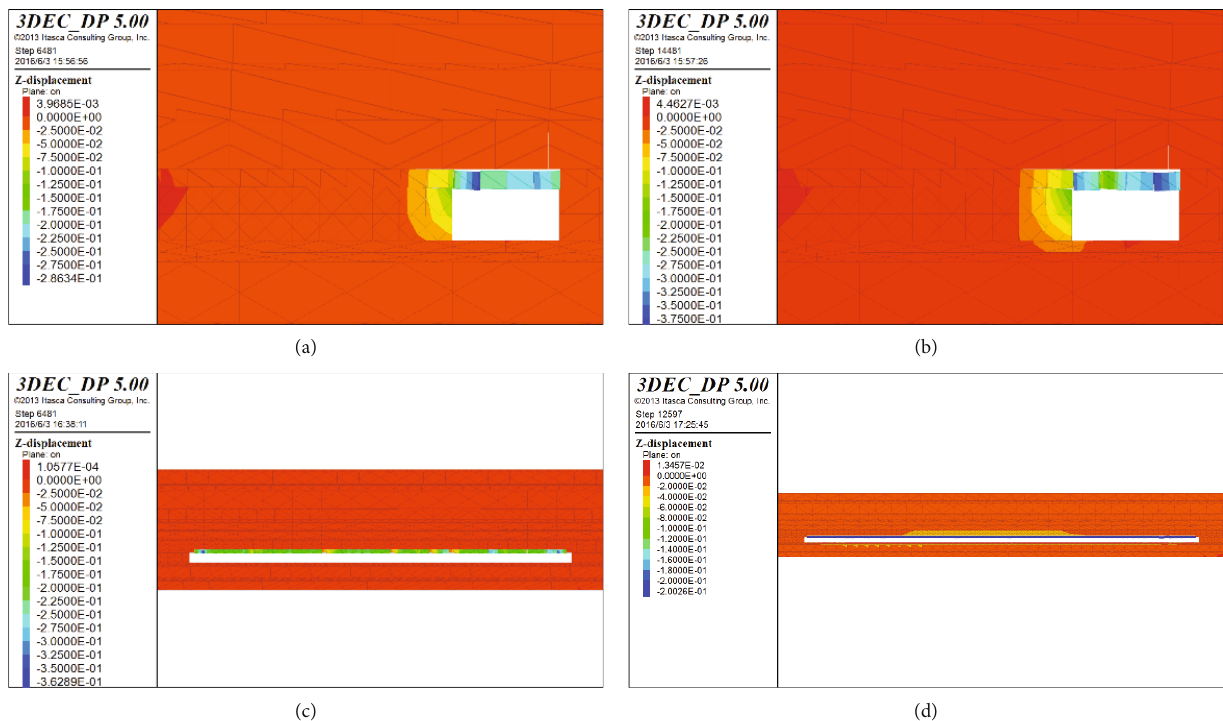
Figure 3: Nephogram of roof strata displacement when advancing to 15m (unit: m): (a) slice of the 195m working face in advancing direction, (b) slice of the 376m working face in advancing direction, (c) lengthwise slice of the 195m working face, and (d) lengthwise slice of the 376m working